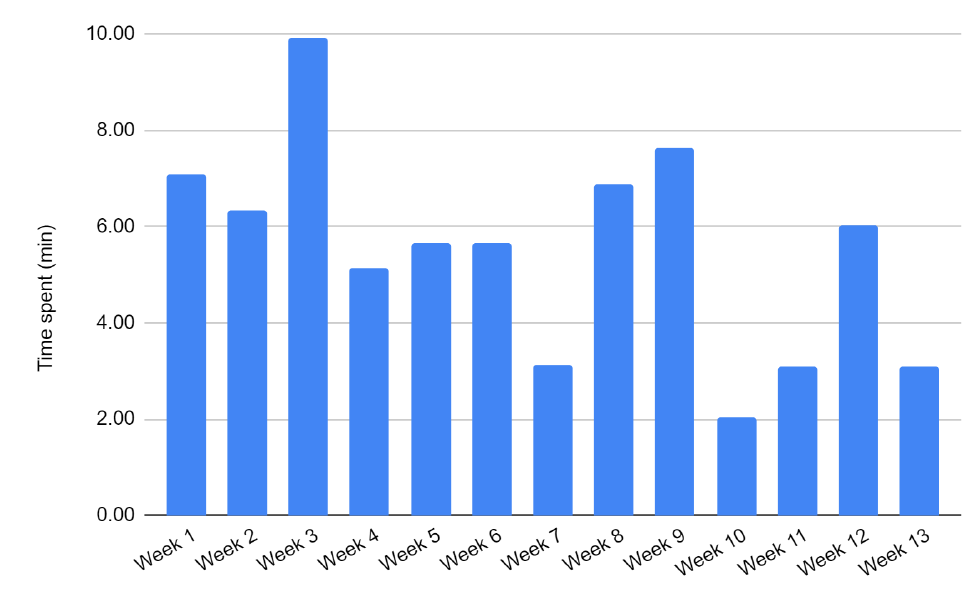
Figure 7. Average time spent per exercise, per week.